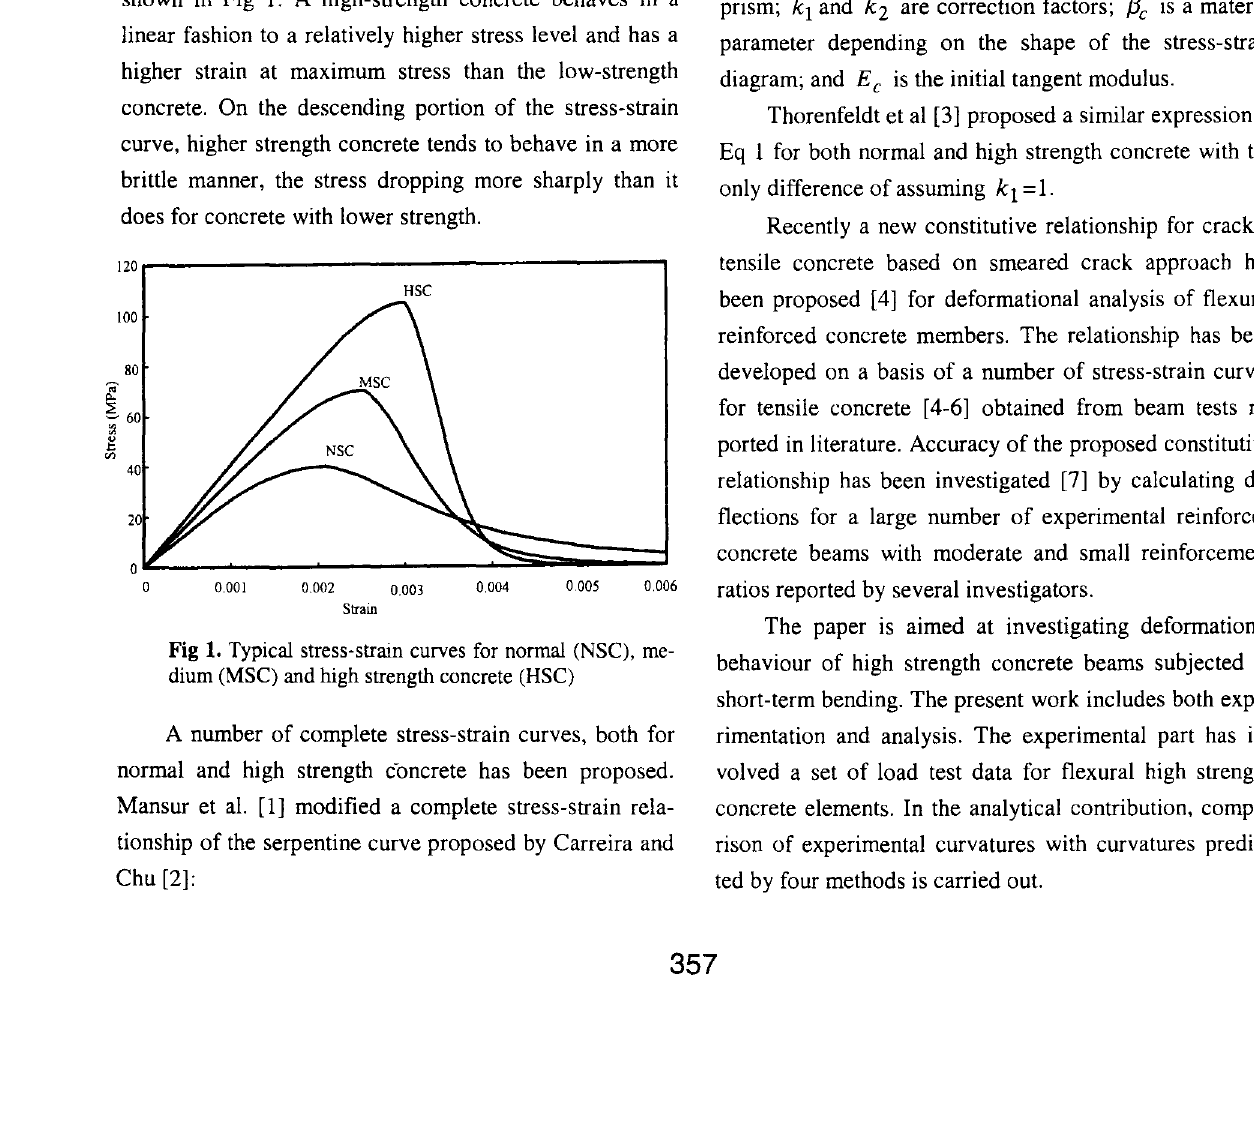
Fig 1. Typical stress-strain curves for normal (NSC), me dium (MSC) and high strength concrete (HSC) A number of complete stress-strain curves, both for normal and high strength c-oncrete has been